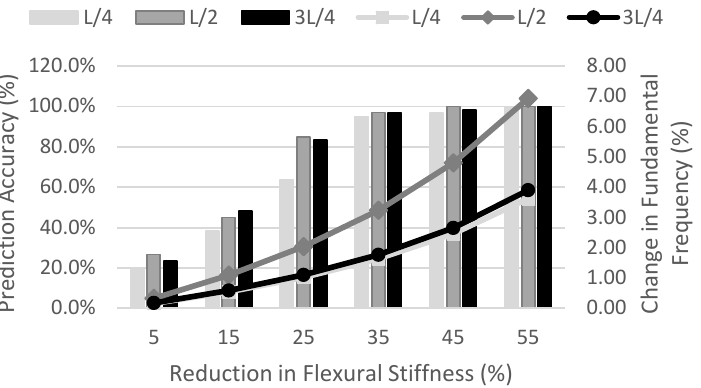
Figure 12. Prediction accuracy of damage detection algorithm for different levels of damage and different locations.